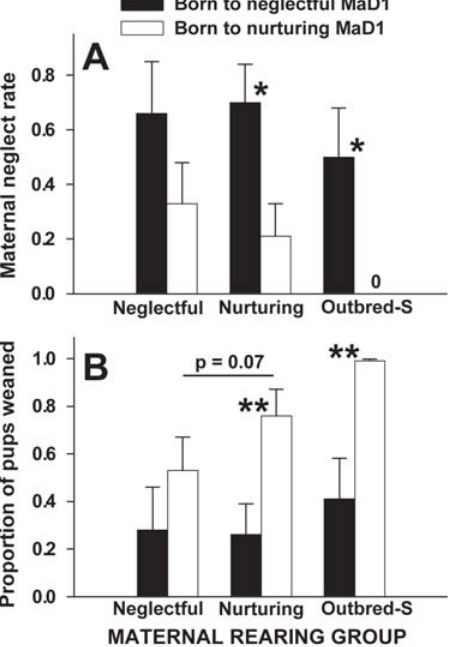
Figure 3. Pups born to previously neglectful mice elicit decreases in maternal care. When raised by either previously nurturing MaD1 mice or Outbred-S mice, pups that were born to previously neglectful MaD1 mothers received significantly higher levels of maternal neglect relative to pups born to previously nurturing MaD1 mice (A). Similarly, the proportion of pups weaned was significantly lower for pups born to previously neglectful MaD1 mothers when raised by either previously nurturing MaD1 mothers or Outbred-S mothers (B). Previously neglectful (relative to nurturing) MaD1 mice weaned a lower proportion of pups when the pups were from nurturing mothers, but the differences did not reach significance (p=0.071). Bars represent means 6 SE. * =p , 0.05; ** =p ,